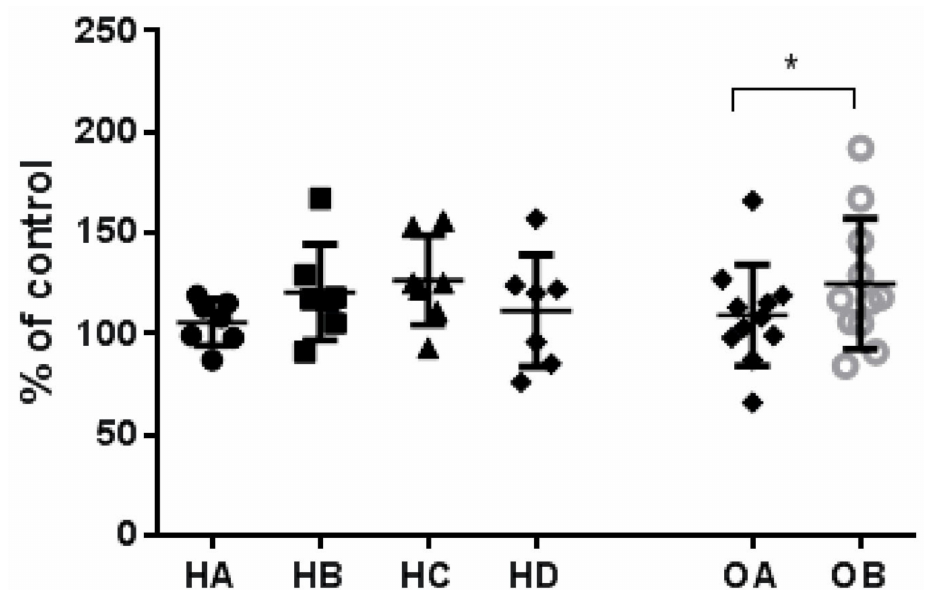
Figure 7. Endothelial cell proliferation after 24h exposition to medium supplemented with serum taken from individuals with genetically determined severe hyperlipidaemia ( n = 6) collected in the regular diet phase (HA), after ten weeks of flaxseed substitution (HB), collected during the “wash out” phase (HC), collected after ten weeks of taking placebo (HD), taken from obese patients ( n = 11) before the administration of flaxseed biscuits (OA), taken from obese patients after a 10 weeks dietary supplementation with flaxseed (OB). The data were expressed as percent of standard control (con = cells maintained in cultured medium supplemented with foetal calf serum) and derived from two independent experiments. Data were analysed using the t -test for the matching pairs (OA, OB). HA, HB, HC and HD were statistically analysed using one-way ANOVA. Statistical significance: * p < 0.05. OA vs.